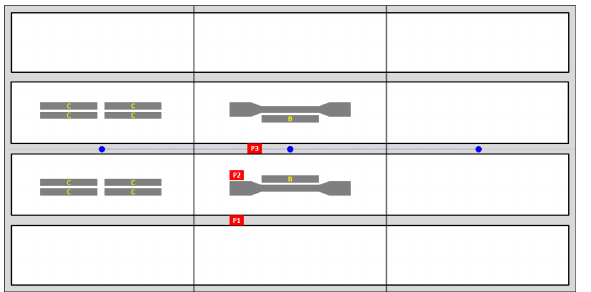
Figure 1. Plate geometry used for the physical foaming trials. Blue dots indicate injection points. Specimens for bending test (marked “B”, 80 × 10 mm²) and tensile test, as well as Charpy impact test (marked “C”, 80 × 10 mm²), are shown in dark grey. Specimens for density test and optical micros- copy (marked P1, P2, P3”, 20 × 15 mm²) are shown in red.